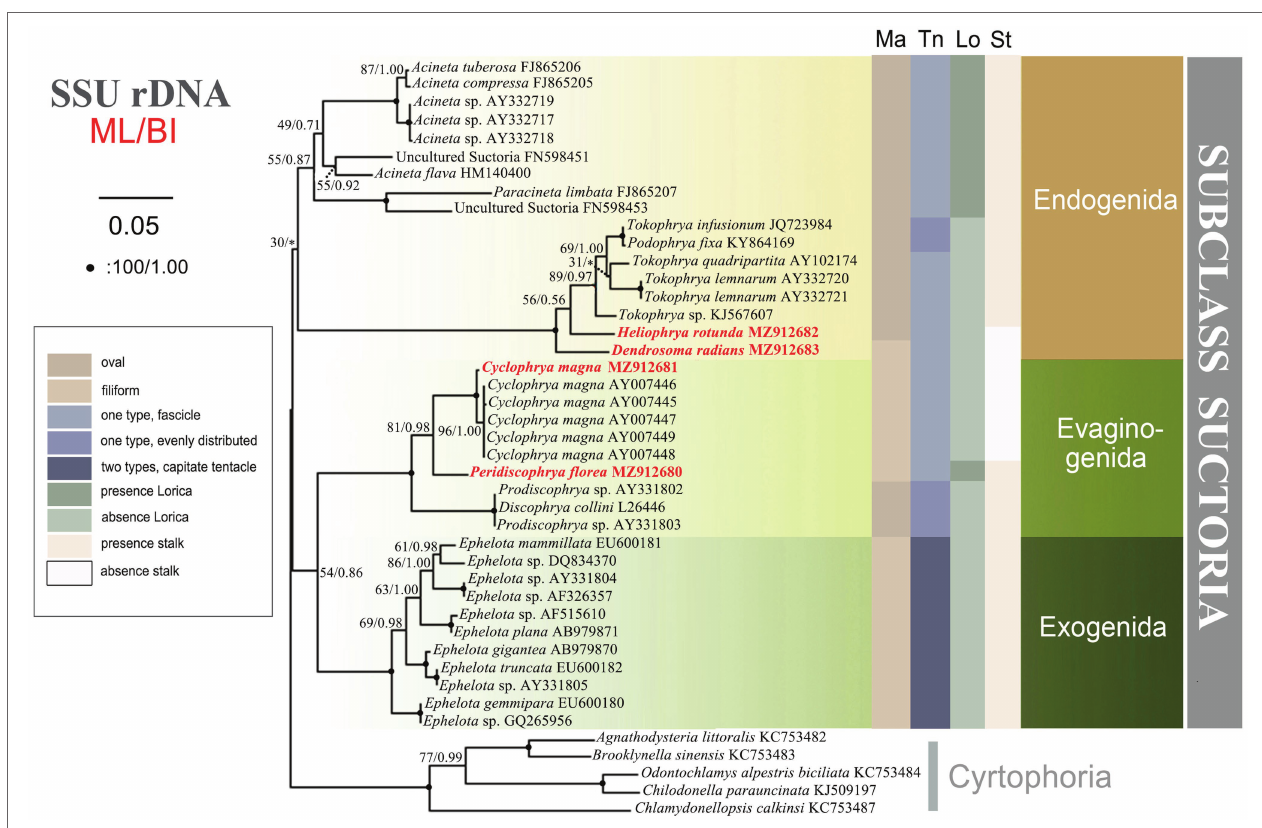
FIGURE 9 | The consensus phylogenetic trees inferred from small subunit ribosomal DNA (SSU rDNA) using maximum likelihood and Bayesian analysis methods. Numbers at nodes represent the bootstrap values of ML and the posterior probabilities of Bayesian analysis (BI), respectively. *the disagreement between BI tree and the reference ML tree. Fully supported (100%/1.00) branches are marked with solid circle. Sequences newly added in the present work are in red. The scale bar corresponds to 5 substitutions per 100 nucleotide